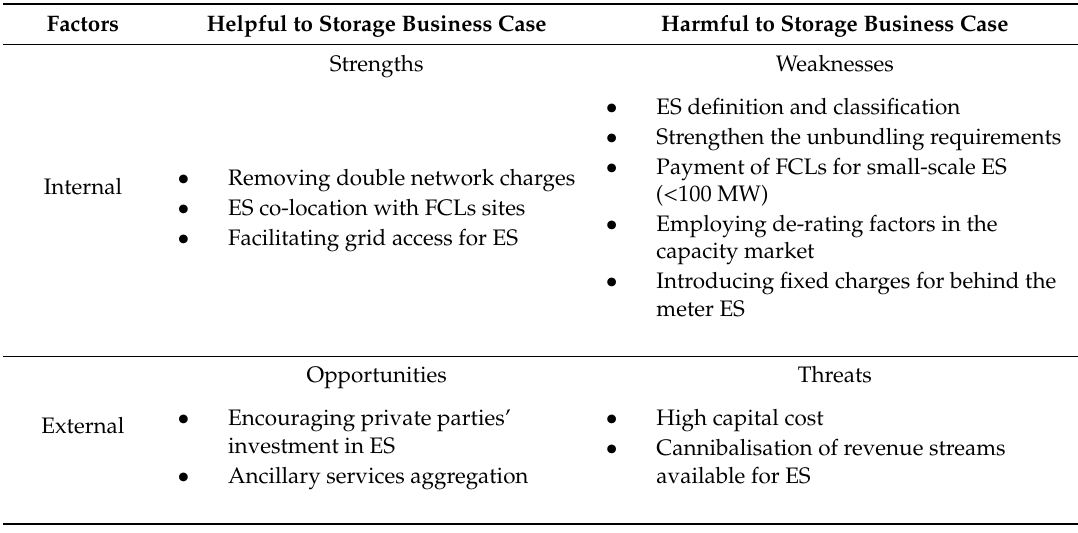
Table 2. SWOT analysis of the market / regulatory changes for ES in the